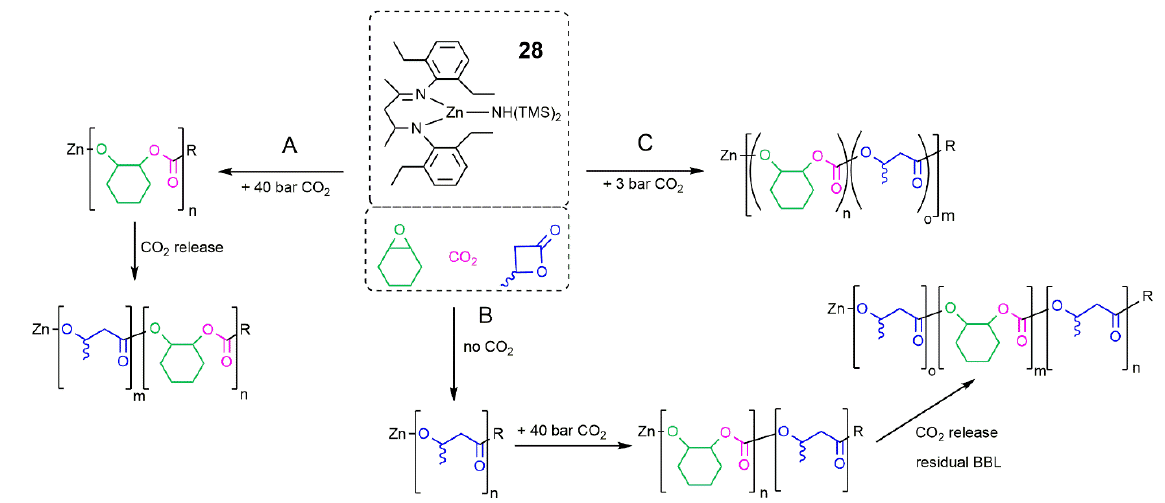
Scheme 7. Different reaction pathway of 28 toward ROP of BBL, copolymerization of CPO with CO 2 , and terpolymerization of CHO, CO 2 and BBL. Reproduced with modification and permission from ref [53]. Copyright (2017) American Chemical Society.